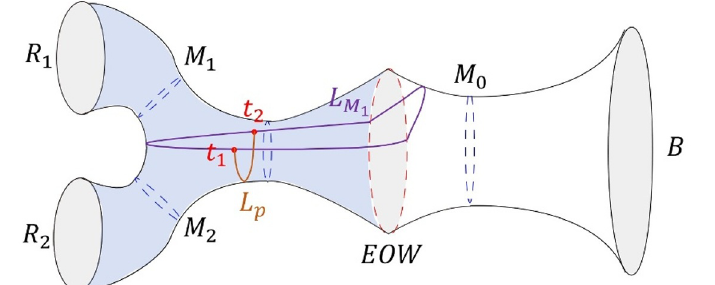
which crosses the EOW 1